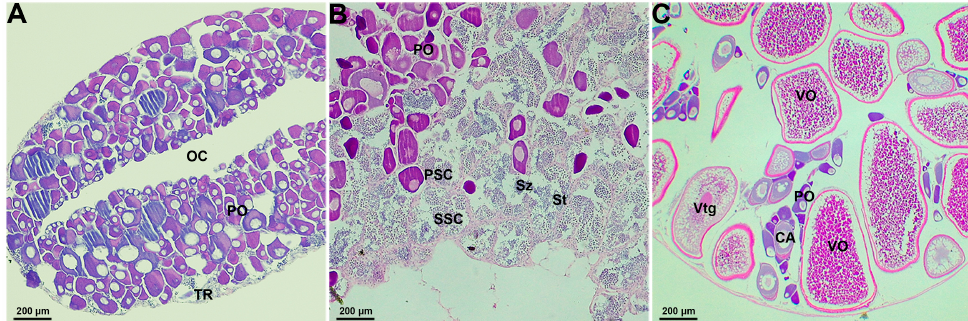
Figure 1. Gonadal histological characteristics of A. clarkii at different social ranks. ( A ) Ovotestes of nonbreeders consist of primary oocytes with smaller area of testicular region. ( B ) Ovotestes of males comprise the large area of testicular region in the center surrounded by primary oocytes at the periphery. ( C ) Ovaries of females with all stages of oocytes. TR: testicular region; OC: ovarian cavity; PO: primary oocytes; PSC: primary spermatocyte; SSC: secondary spermatocyte; St: spermatids; Sz: spermatozoa; CA: cortical vesicle stage oocytes; Vtg: vitellogenesis stage oocytes; VO: vitellogenic oocytes. Scale bars = 200 μ m.